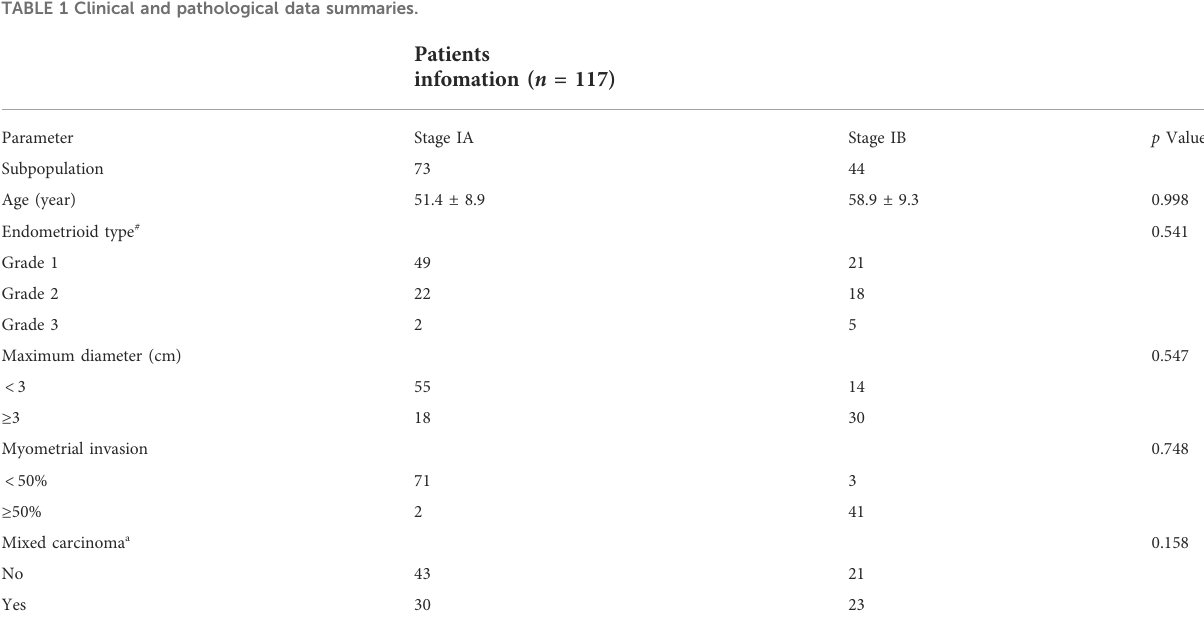
TABLE 1 Clinical and pathological data